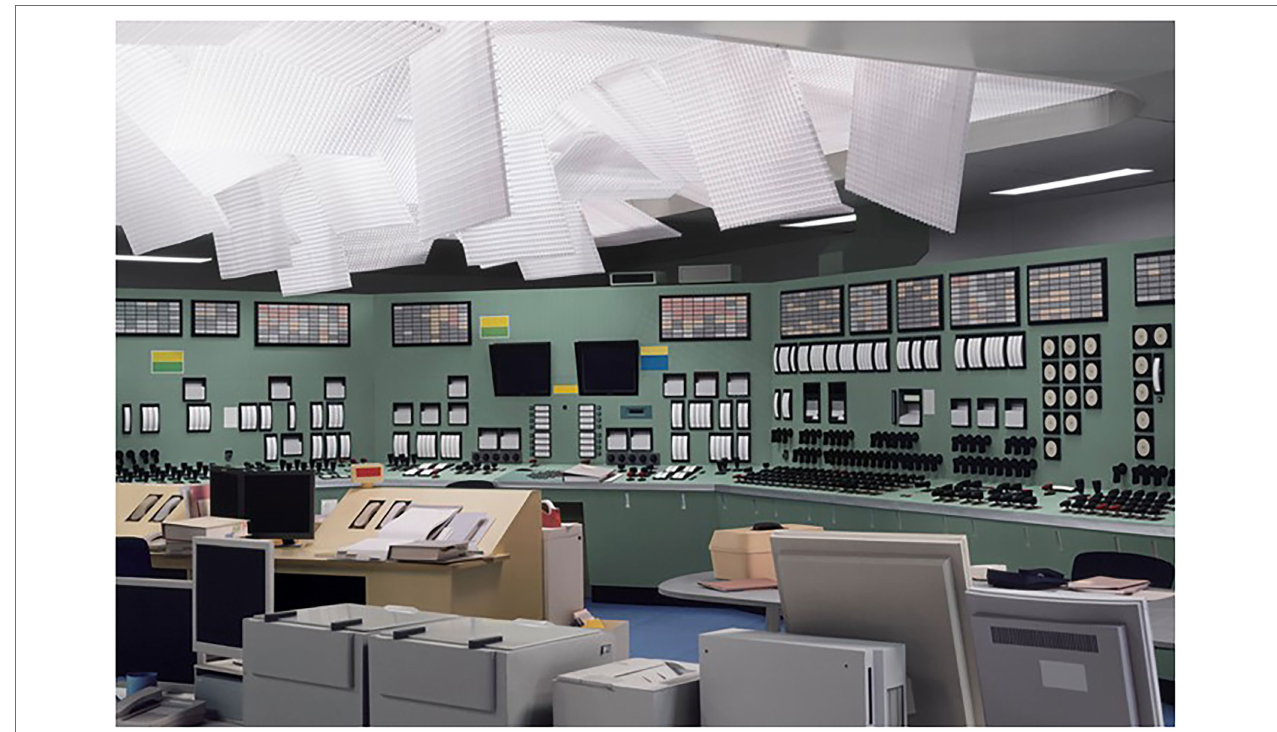
FIGURE 3 | Thomas Demand’s Kontrollraum/Control Room (2011), C-Print/Diasec, 200 × 300 cm © VG Bild-Kunst, Bonn. Courtesy Sprüth Magers Berlin London. Reproduced with